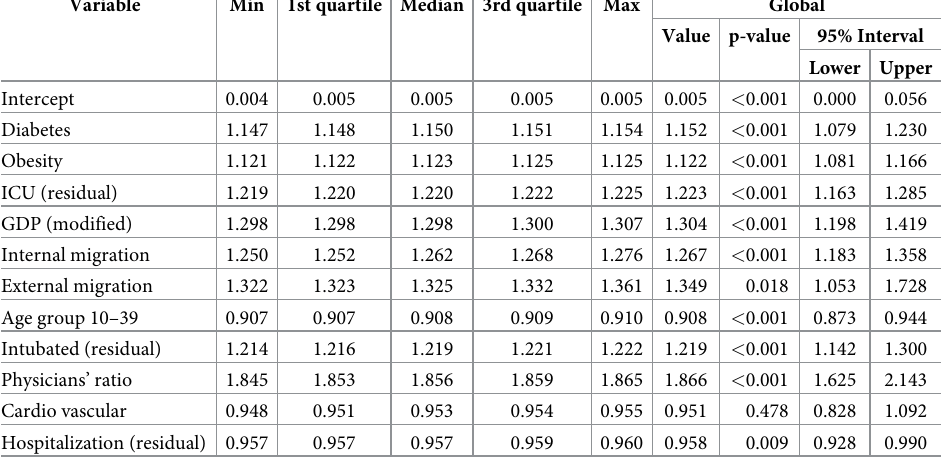
� Multiplicative changes in the risks (MRt) from the effects of the different risk factors by state. �� Offset: Log of the total number of people tested in a